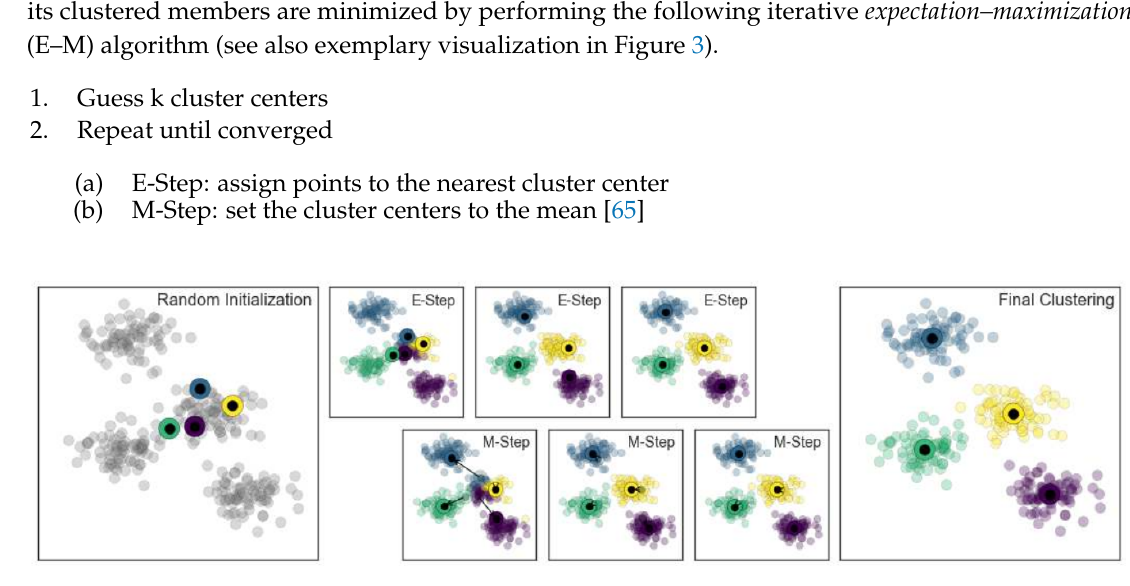
Figure 3. Exemplary visualization of the E–M algorithm for k-means clustering [65]. During the E-Step, all data points are assigned to the nearest (initially randomly set) cluster center. Afterwards each cluster center is reset to the centroid of its current cluster. These steps are repeated until